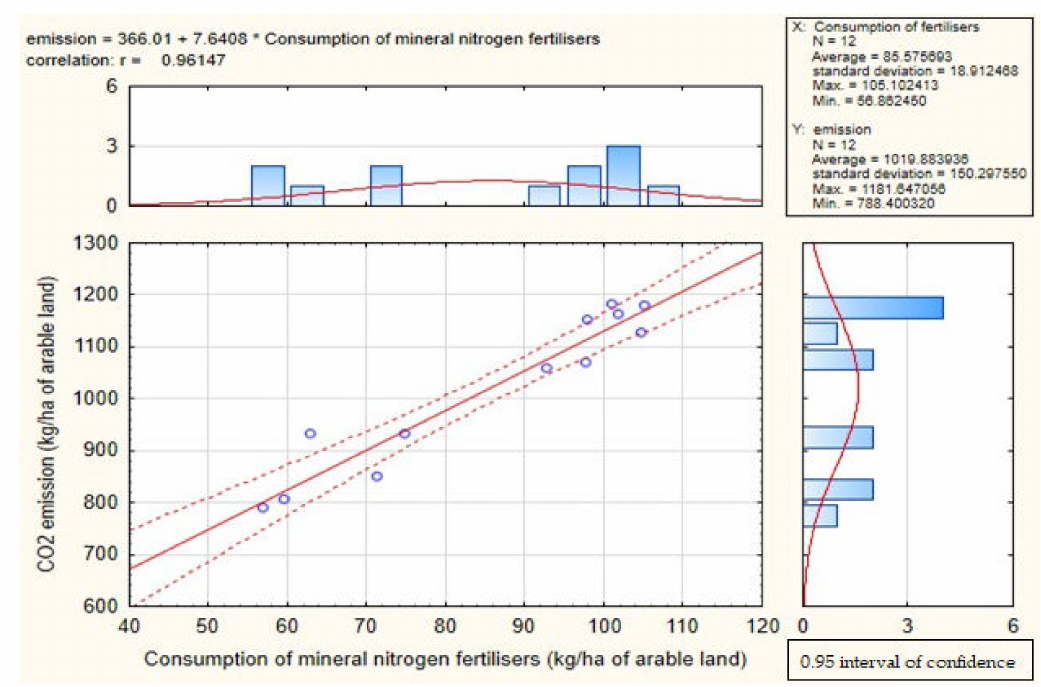
Figure A2. Results of correlations analysis: Bulgaria. Source: own calculation based on Eurostat. Note: purple dot: observation, red solid line: linear function, red dashed lines: 95% interval of confidence.